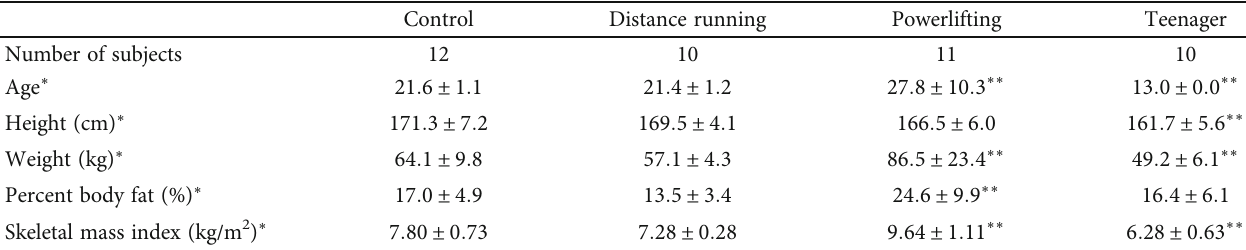
Table 2: Summary of research participants.